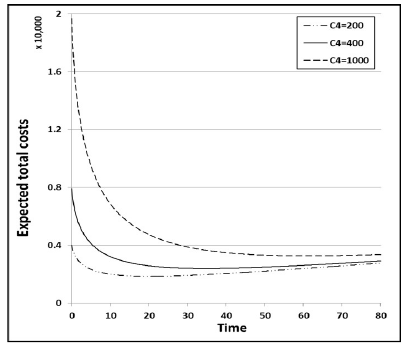
Figure 16. Expected total cost according to cost coefficient C 4 for the 1 st condition.